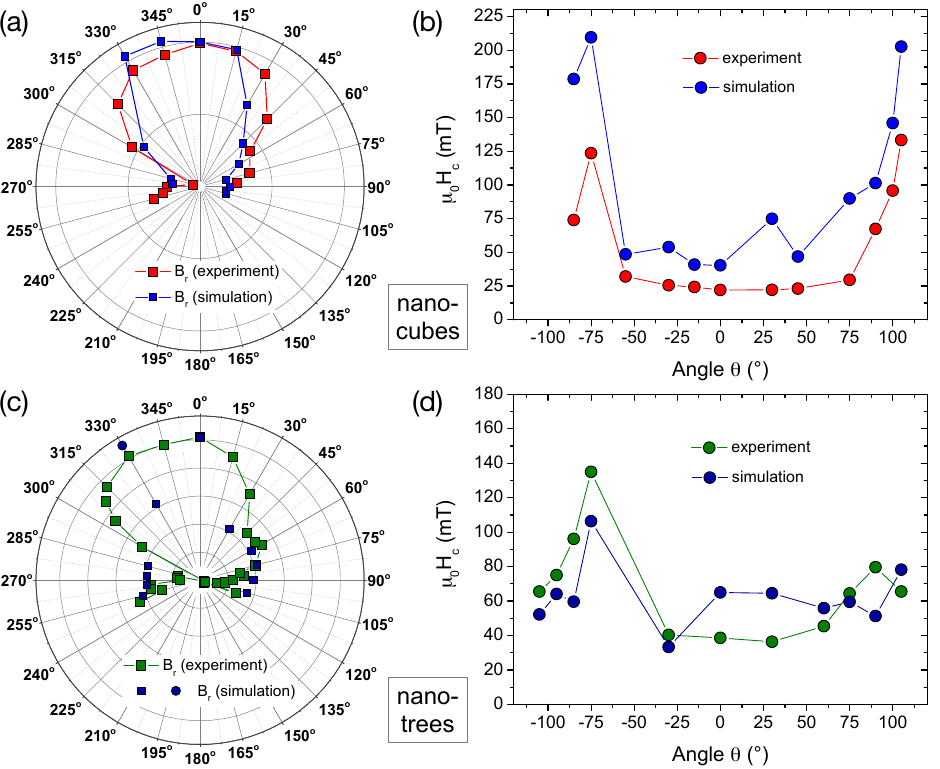
Figure 7. ( a , c ) polar plots of the angular dependences of the remanent magnetization (stray field B r ) comparing the experimental and simulated results (scaled to the values at θ = 0 ◦ ) for the nano-cubes and nano-trees, respectively; ( b , d ) linear plots of the angular dependences of the measured and simulated ’coercive fields’ µ 0 H c determined by evaluating the ’area’ curves (down-sweep minus up-sweep) and taking half the value of the full-width-at-half-maximum for both nano-cubes and -trees. Lines are guides to the eyes. (At θ = 30 ◦ , this method yields a too small value for the simulated − hysteresis, likely due to the configuration being ’trapped’ in a metastable state. Reading just the value in the demagnetized state for the down-sweep curves, circle in ( c ), results in a better correspondence with the